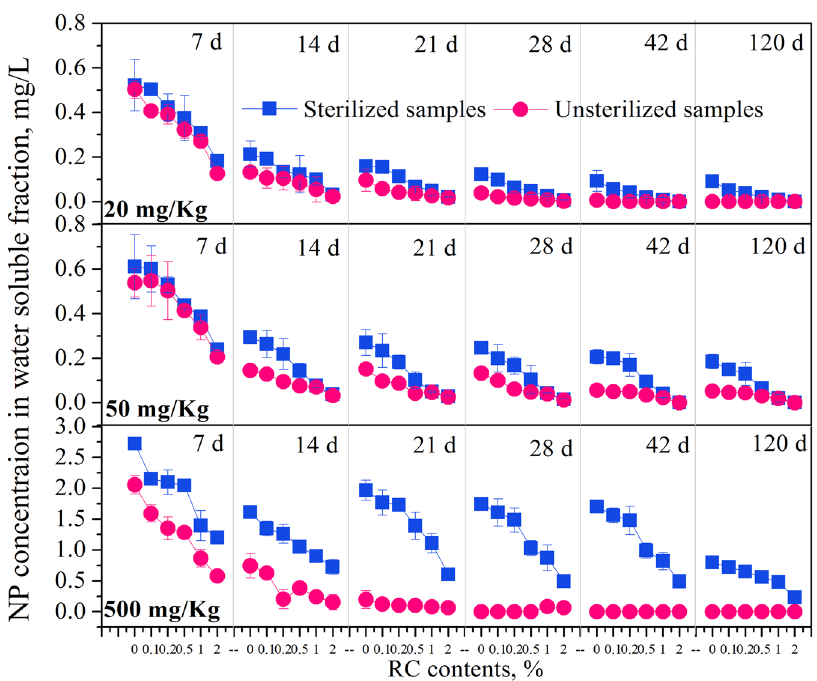
Figure 3. Changes of NP concentration in water soluble fraction with time in RC-sediment